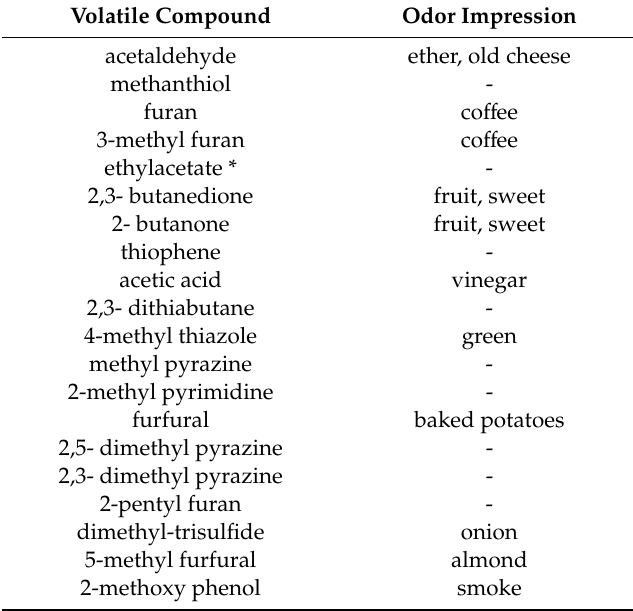
Table 2. Volatile compounds specific to roasting of cactus seed